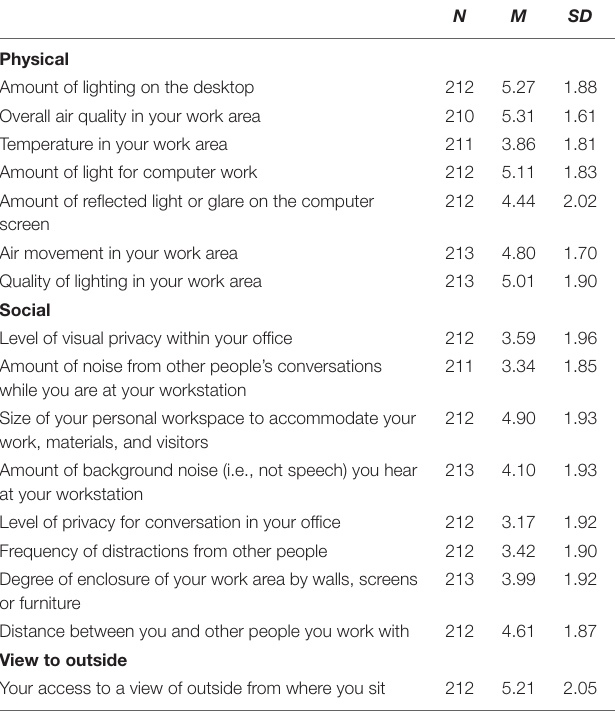
TABLE 1 | Environmental features rating (EFR) – items and descriptive